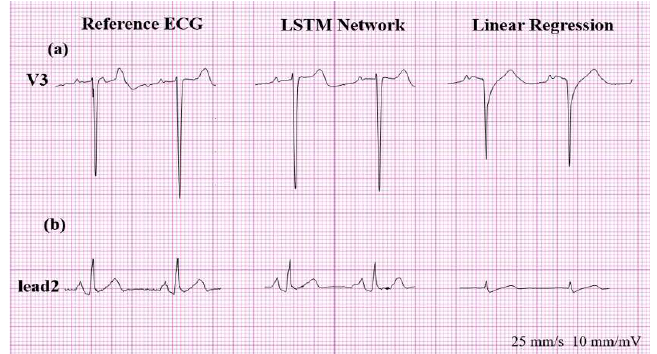
Figure 10. ( a ) False positive wide QRS in the reconstructed ECG using LR. ( b ) Large differences in